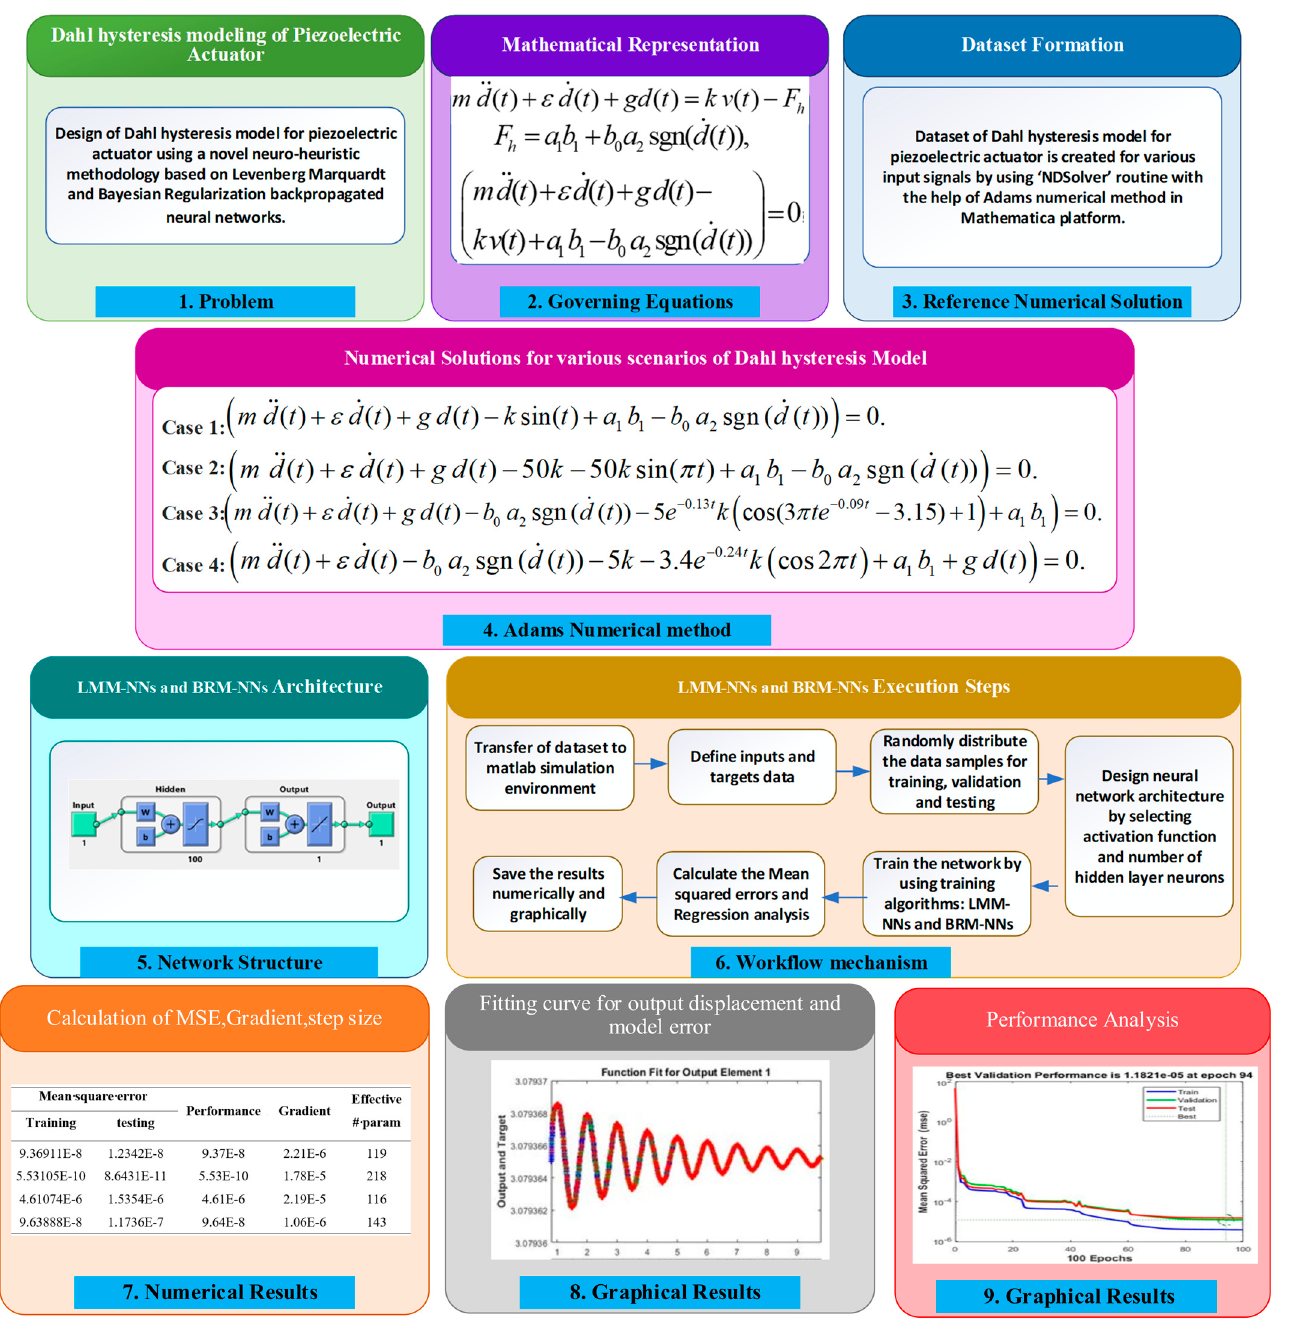
Figure 2. Graphical abstract for a proposed methodology of LMM-NNs and BRM-NNs for piezoelectric actuator.